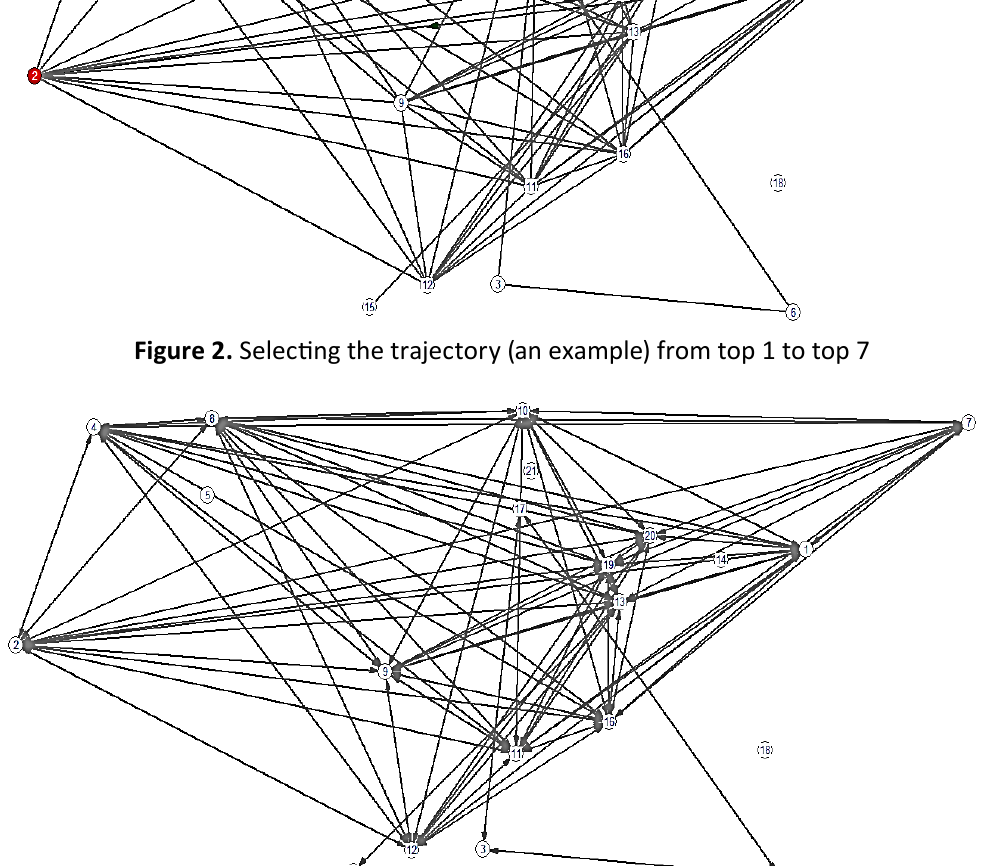
Figure 3. General view of the oriented link graph for banks with direct